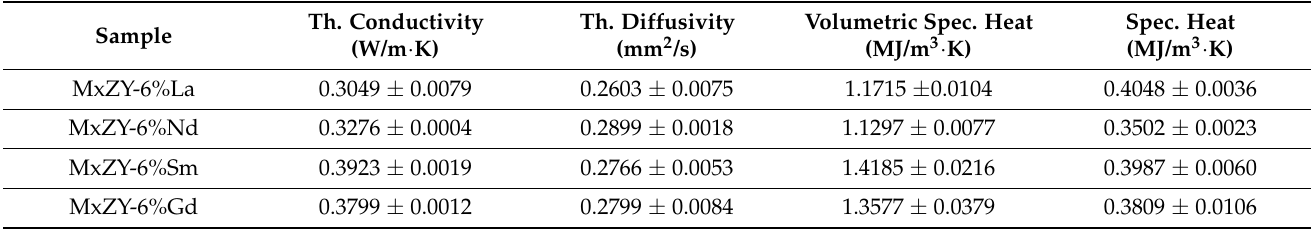
Table 5. Thermal properties of ZrO 2 co-doped with 8 wt.% Y-6% Ln (Ln = La, Nd, Sm,